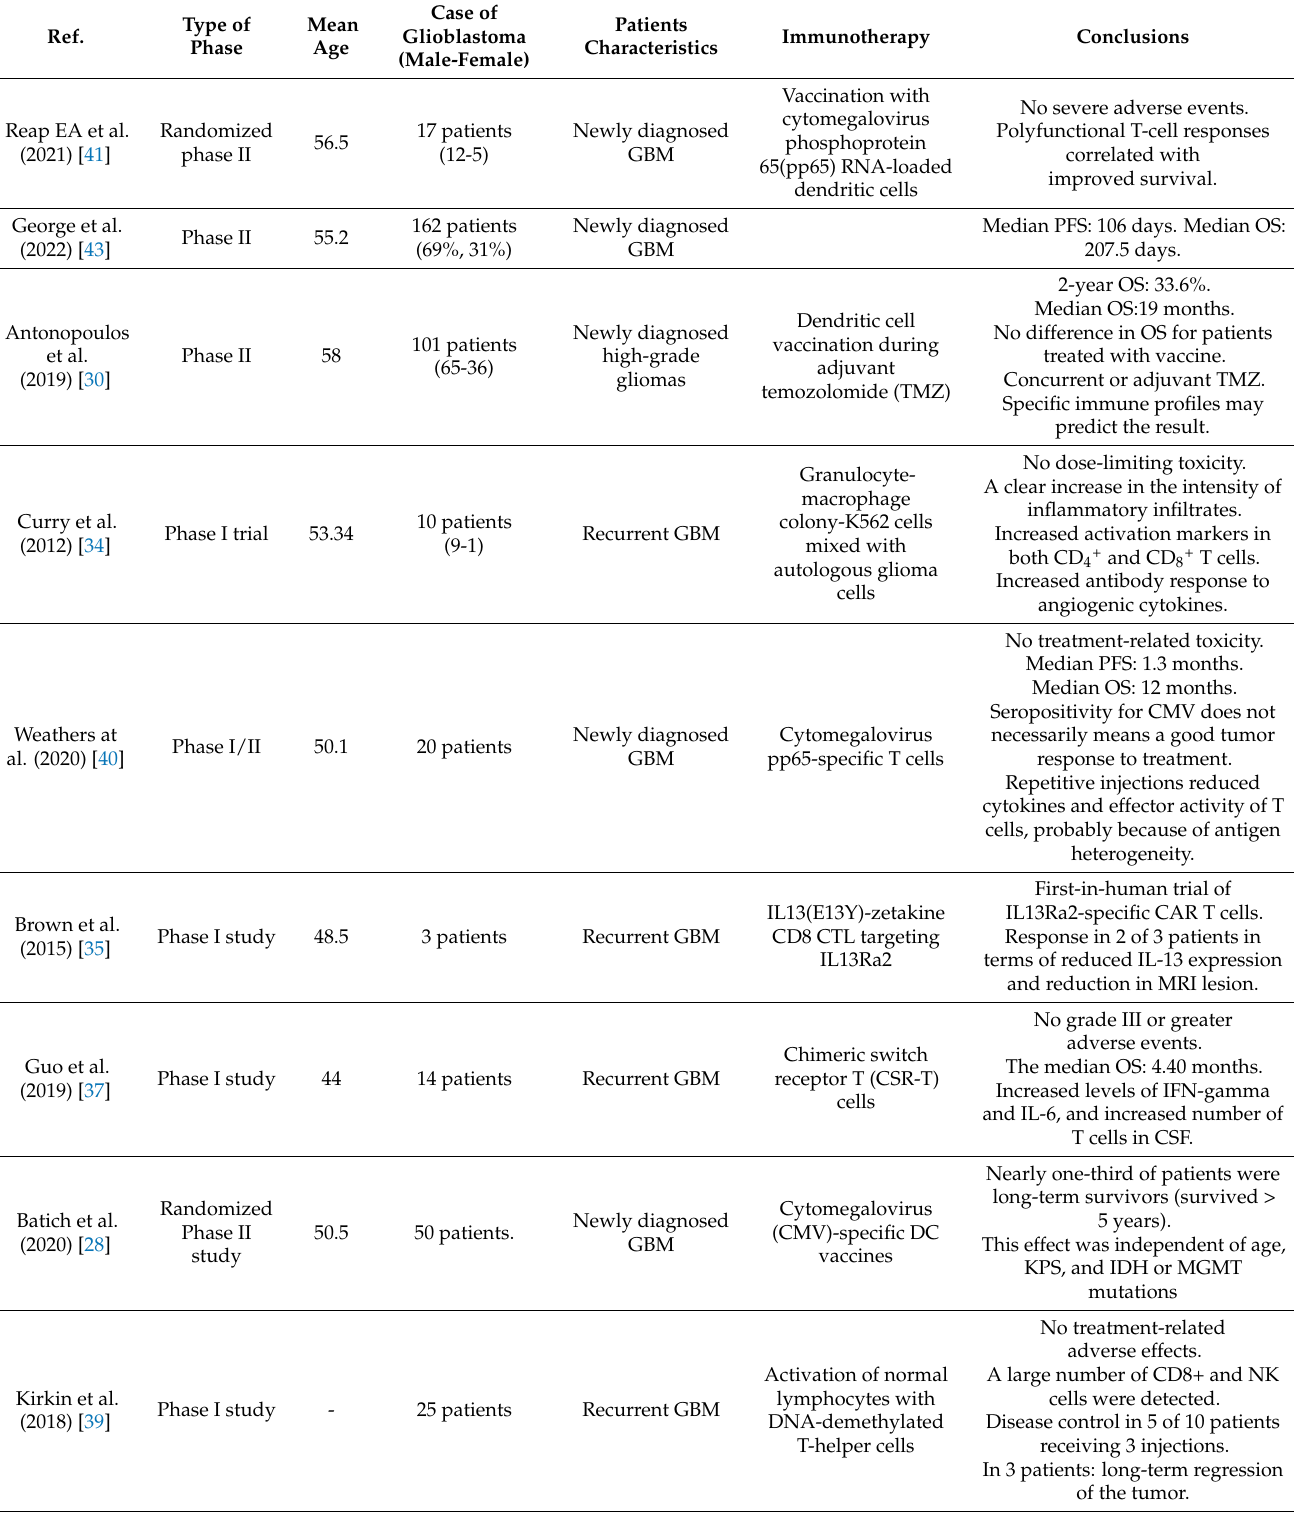
Table 1. The primary features and outcomes of the selected